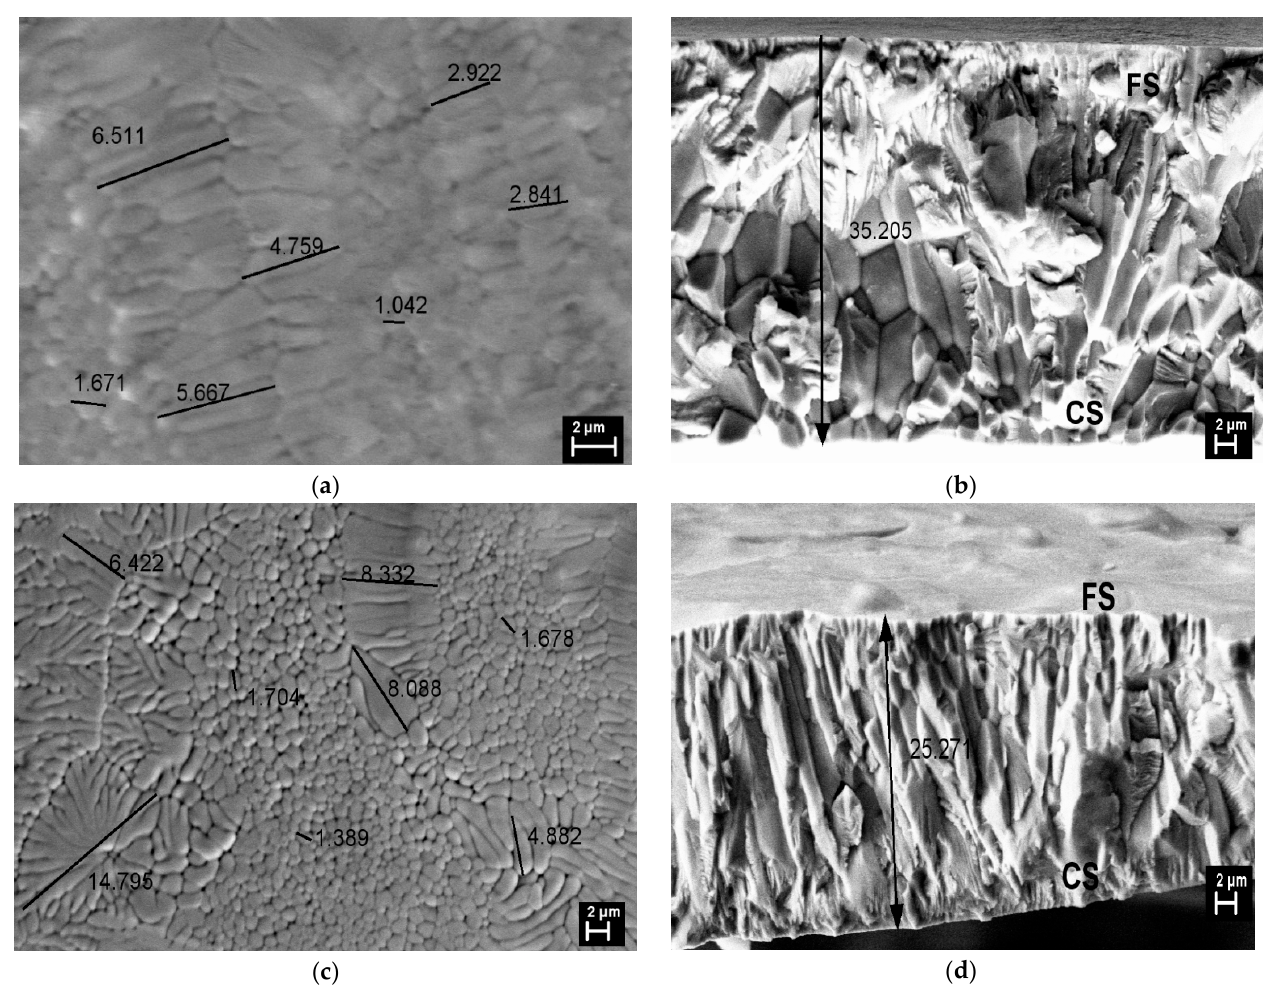
Figure 2. SEM images on FS and the fractured cross-section for Mn-AP ( a , b ) and Mn-TT ( c , d ). For the Mn-AP ribbons (Figure 2a), the SEM image shows a mixture of cellular and dendritic structures, with small grain sizes between 1–6.5 µ m without the specific martensitic relief. The substantial grain refinement is an effect of rapid quenching at a high wheel velocity [21]. The dendritic structure is also a result of the rapid solidification and the high temperature gradient between liquidus and solidus, specific to the off-stoichiometric Ni-Mn-Ga alloys [22]. Figure 2b, on the fractured cross-section, indicates the equiaxial and columnar grains from the contact surface (CS) with the copper wheel to the free surface (FS). The presence of the columnar grains is a microstructure signature of the fast nucleation and growth process along the cross-section during the rapid cooling of the melt due to the temperature gradient typical for the melt-spinning technique [23]. Rama-Rao et al. [22] claim that the microstructure of ribbons gradually changes during the processing route to the dendritic structure when a concentration variation of the elements appears, especially in Ni. The SEM image on the Mn-TT surface indicates the increase in the cellular and dendritic grain size (the last ones up to 15 µ m) due to the stress release and defects density reduction (Figure 2c). The fractured cross-section structure shows that the morphology changes with TT, being a noticeable improvement of the columnar microstructure without equiaxial grains or precipitates (Figure 2d). According to the previous studies performed by our group [24,25], and also as suggested by XRD (Figure 1), the treatment temperature of 400 ◦ C (673 K) is enough to promote the ordering of the structure and the growth of crystallites. We also mentioned that, since the thermal treatment is not performed in situ at SEM, different parts of the samples are imaged before and after